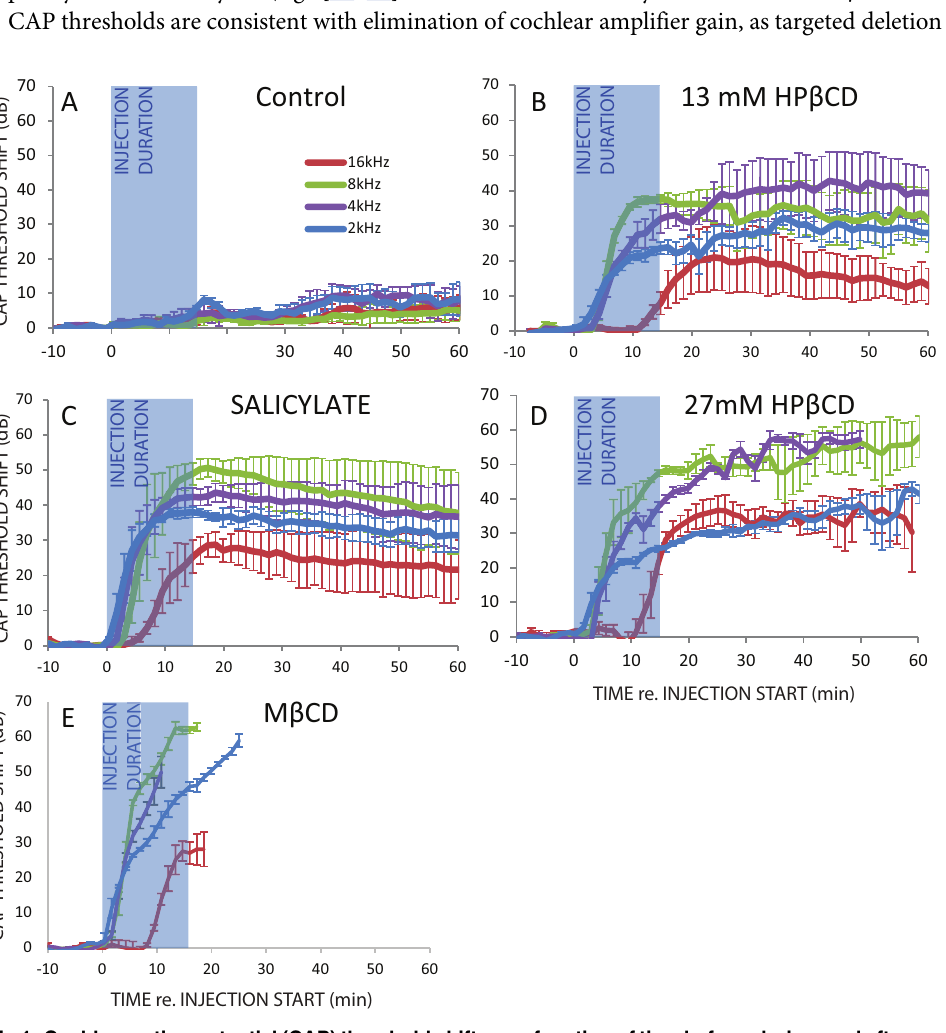
PLOS ONE | https://doi.org/10.1371/journal.pone.0175236 April 6,